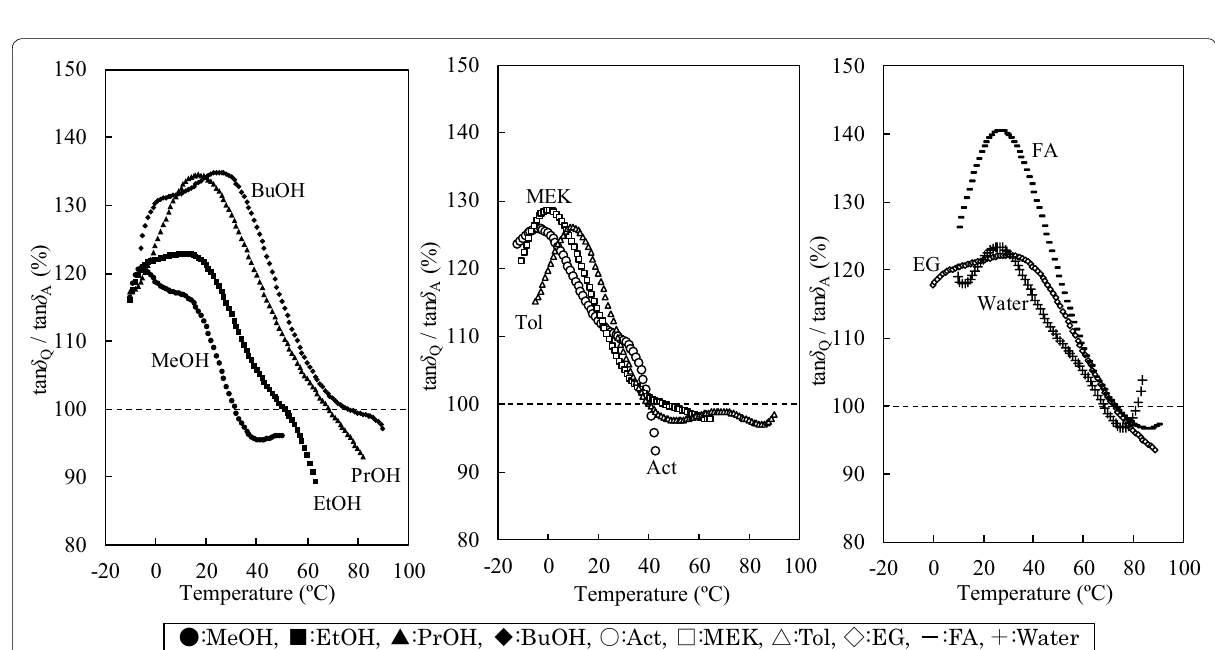
Fig. 5 tan δ Q /tan δ A of acetylated samples swollen by water or each organic liquid. The tan δ Q is the tan δ measured after quenching. The tan δ A is the tan δ measured after